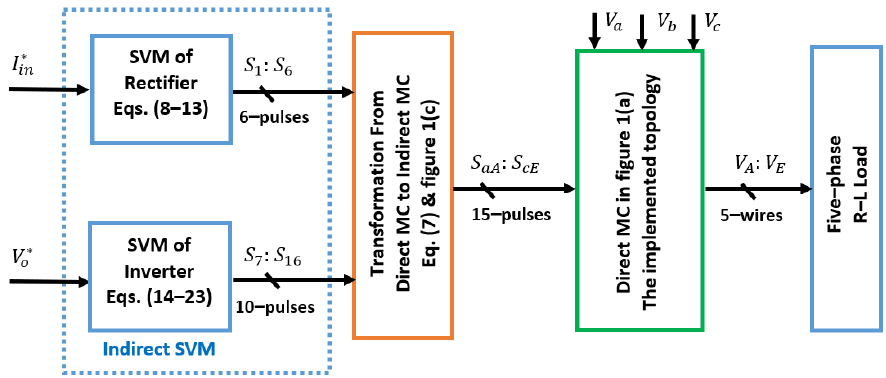
Figure 5. Block diagram for the implementation of the direct topology.